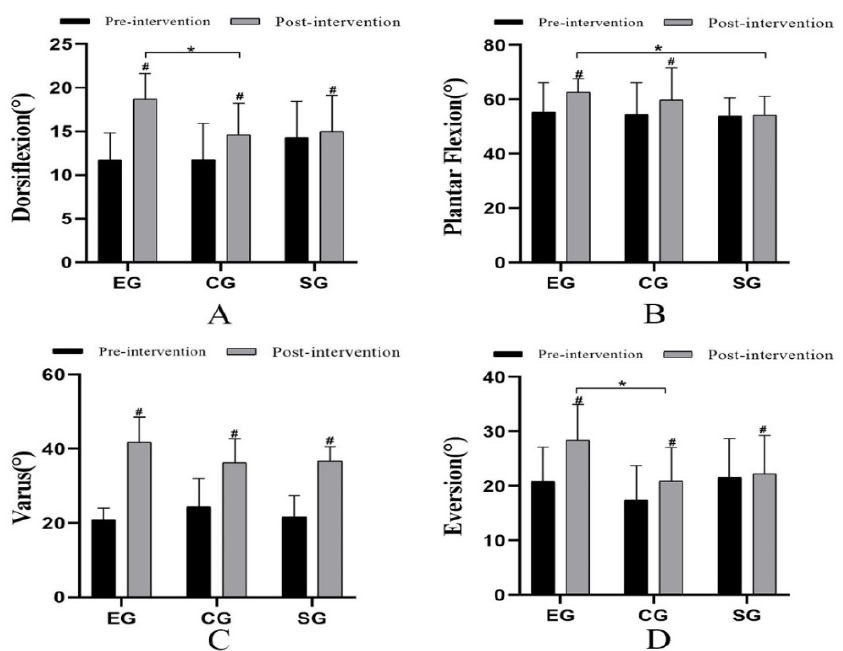
Figure 3. Comparison of range of movement ( ◦ ) among the three groups. # Comparison between groups; * Significant when compared with the EG group ( p < 0.05). (( A ): Dorsiflexion ankle range of movement; ( B ): Plantar flexion ankle range of movement; ( C ): Varus ankle range of movement; ( D ): Eversion ankle range of movement)